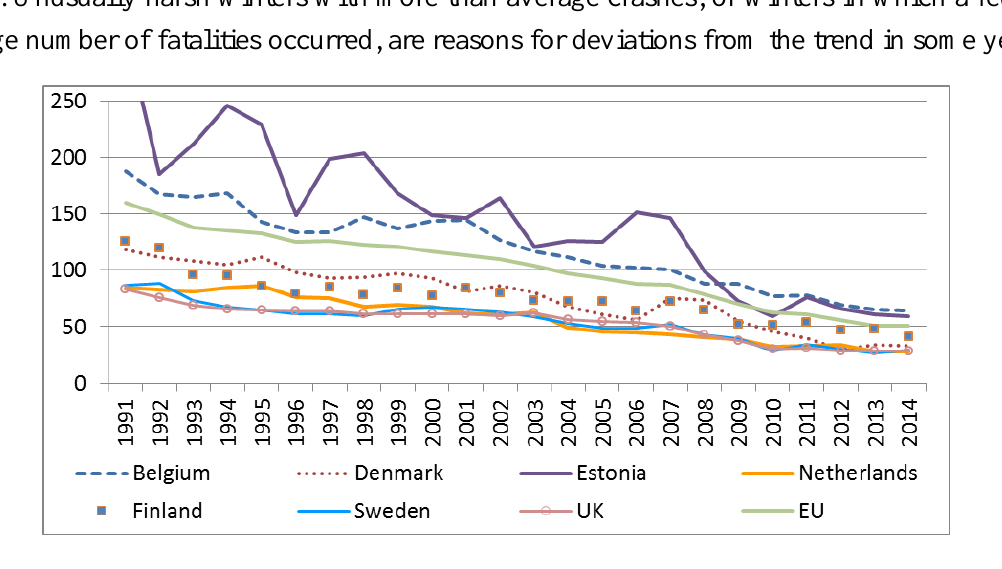
Figure 1. Number of fatalities per million inhabitants. Source: EC DG Mobility and Transport—Road Safety Statistics website